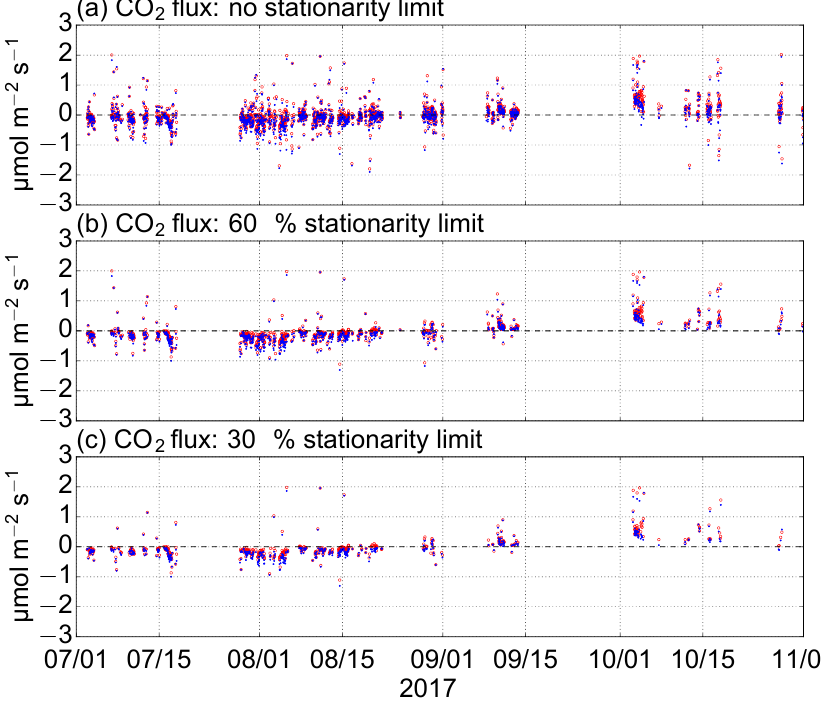
< 0 . 6 and (c) RN < w (cid:48) c (cid:48) w (cid:48) c (cid:48)